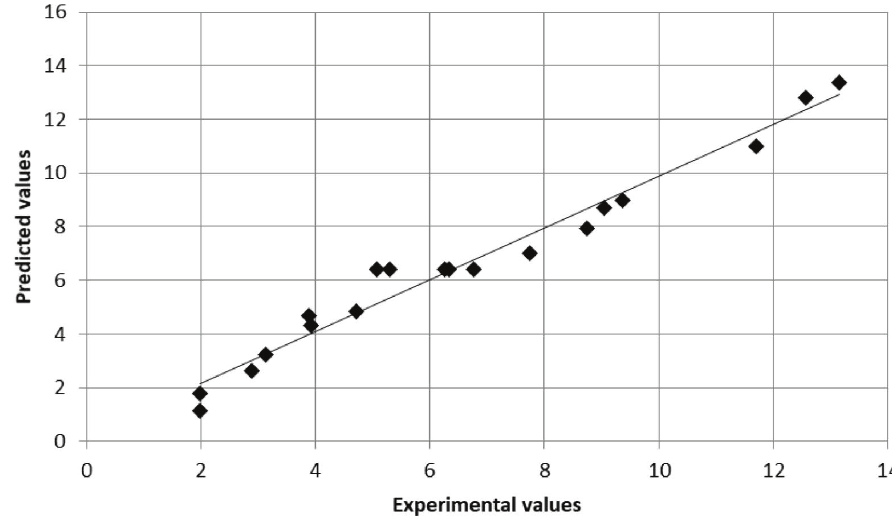
Fig. 2 – Predicted vs observed values (Yield %)